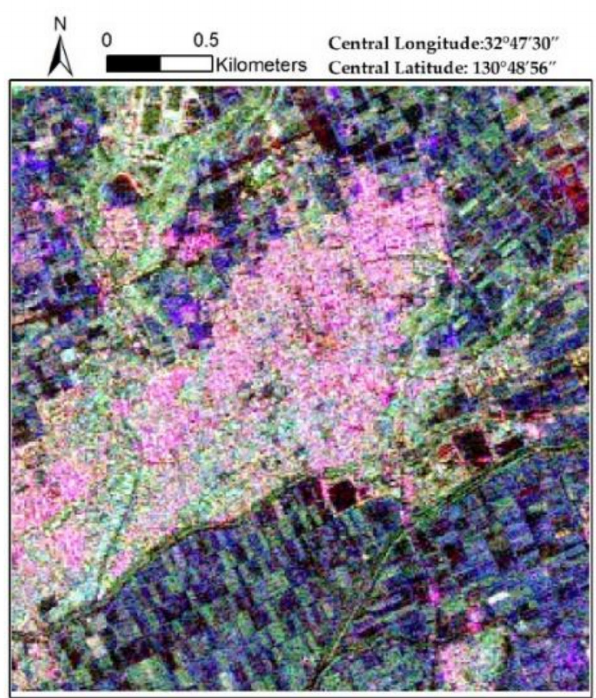
Figure 6. The Pauli RGB image of the ALOS-2 PolSAR data in Mashiki